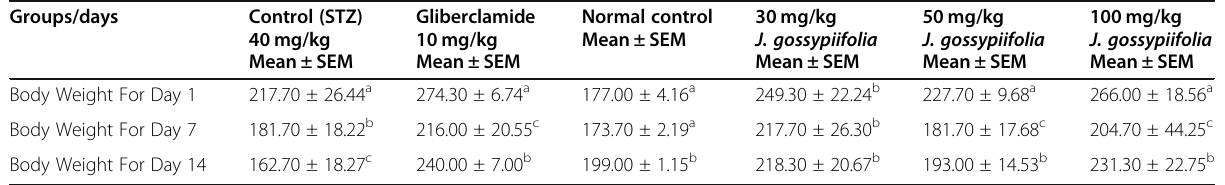
Table 4 Effect of J. gossypiifolia on body weight on hyperglycemic animals Groups/days